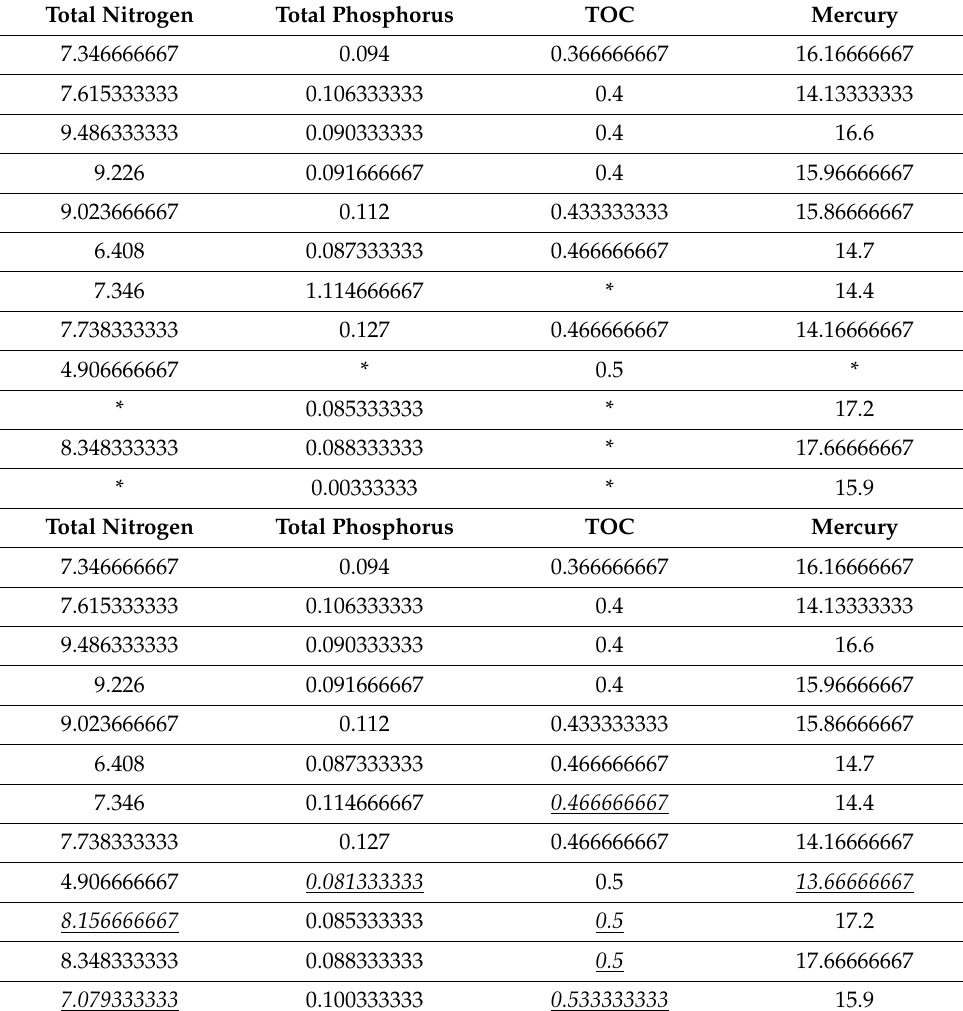
Table 3. Replace processing for missing value (upper: original data, lower: replaced missing